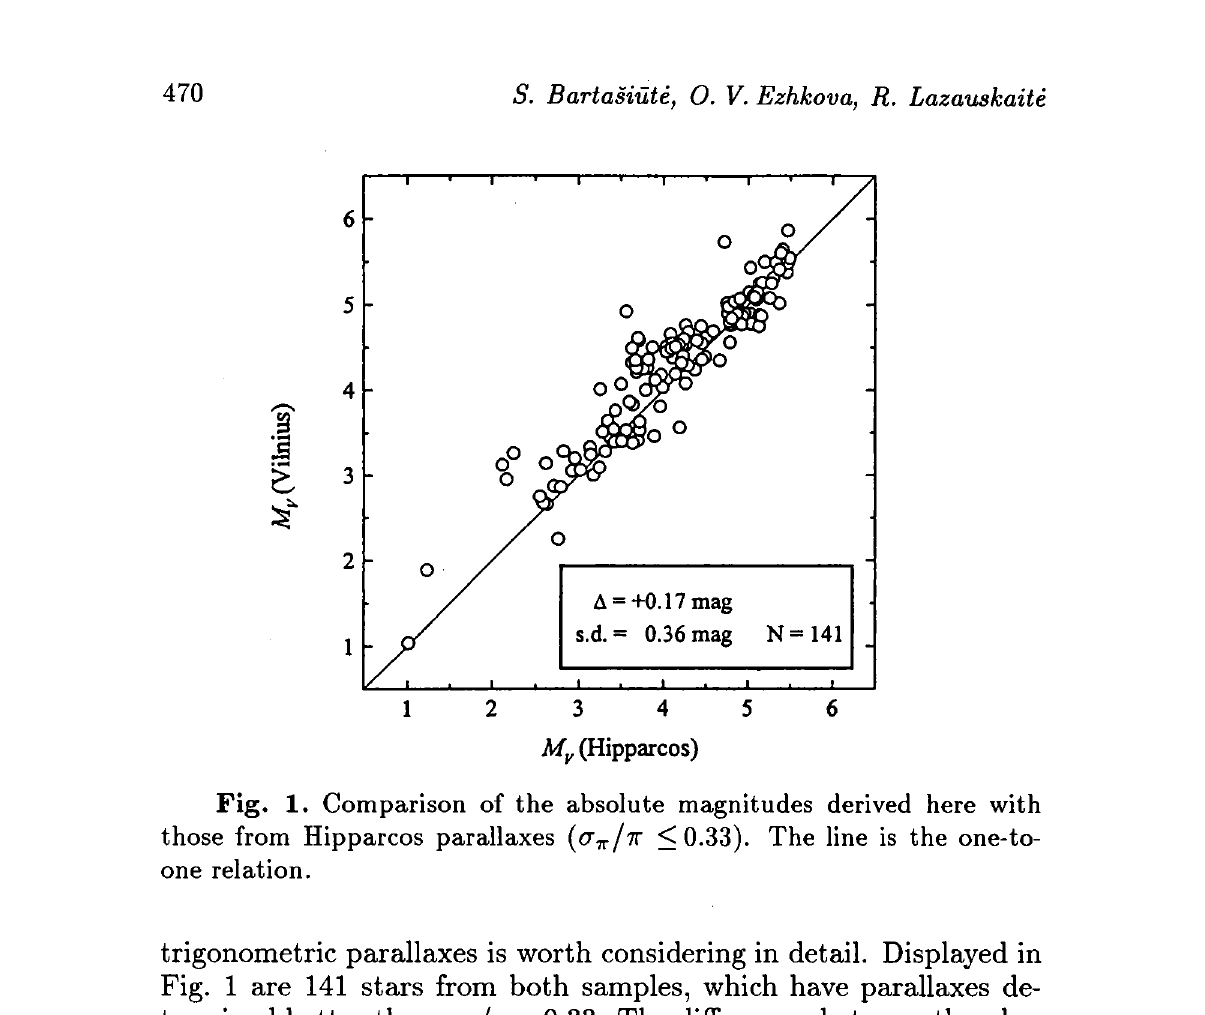
Fig. 1. Comparison of the absolute magnitudes derived here with those from Hipparcos parallaxes (( T ^/ TT <0.33). The line is the one-to- one